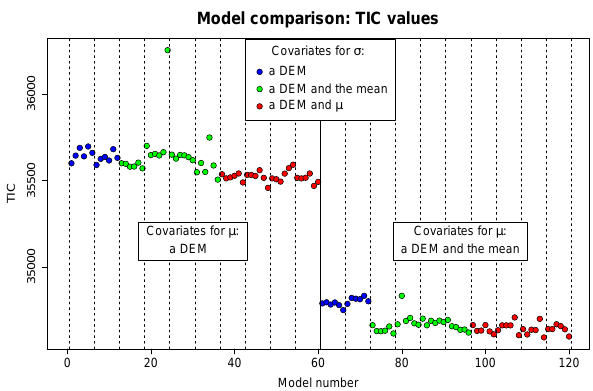
Fig. 6. Model comparison using TIC for two out of the six con- Fig.6. Model comparison using TICfor twooutof thesixconsidered µ models. Models 1 to 60 useaDEM as covariates for µ ; models 61 to 120 use a DEM and the mean snow depth as covariate for µ . Each block sidered µ models. Models 1 to 60 use a DEM as covariates for µ ; delimitedbytwodottedlinescorrespondstoagivenmodelfor µ and σ ,whenallthesixdifferentmodelsfor ξ models 61 to 120 use a DEM and the mean snow depth as covariate areused. for µ . Each block delimited by two dotted lines corresponds to a given model for µ and σ , when all the six different models for ξ are